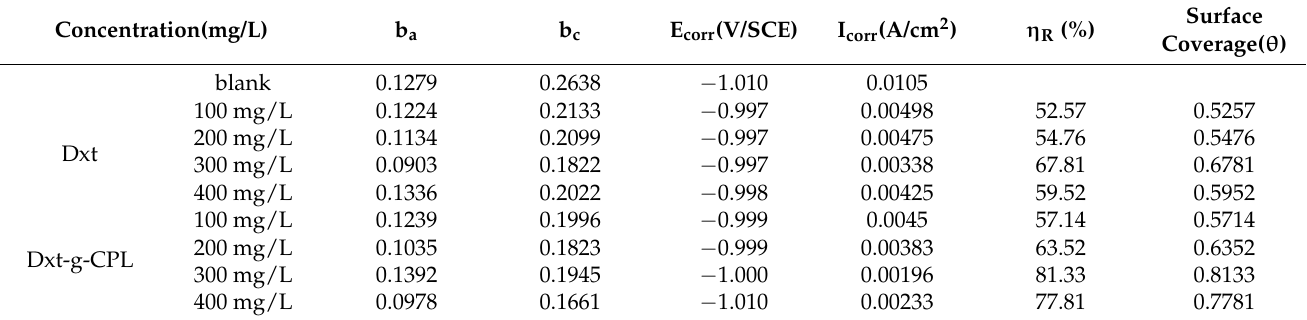
Table 2. Polarization curve-related parameters of J55 steel in 1 M HCl solution with different concentrations of Dxt and Dxt-g-CPL.